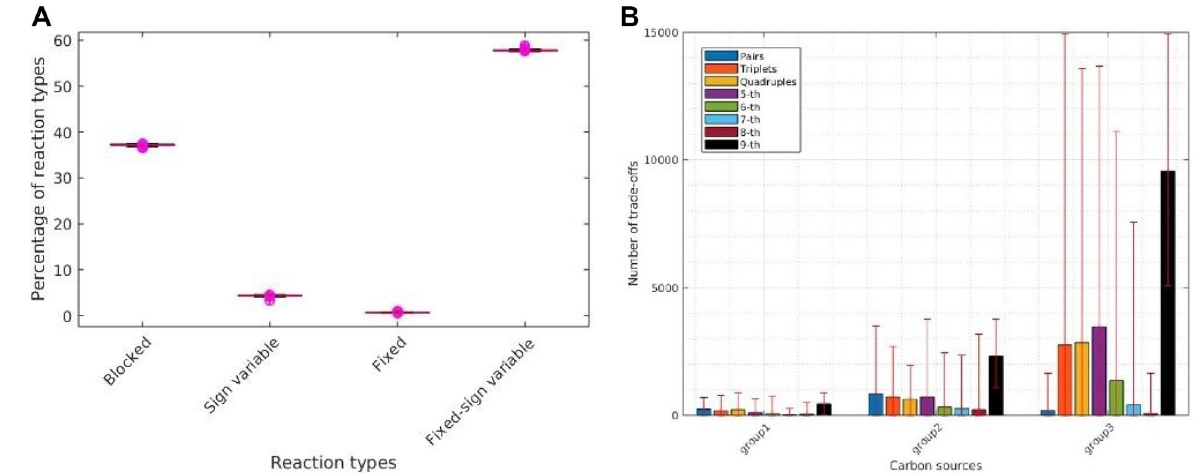
Figure 3. Reaction types based on variability and trade-offs types in E. coli grown under different carbon sources. (A) Box plots showing the percentage of the four reaction types across the 53 carbon sources. (B) Numbers of trade-offs involving a different number of reactions for the 53 growth conditions group in three categories, group 1: (S)-Propane-1,2-diol, N-Acetyl-D-mannosamine, Butyrate (n-C4:0), D-Galactose, D-Glucuronate, Maltose, L-Rhamnose, N-Acetylneuraminate, D-Alanine, L-Asparagine, L-Alanine, Octadecenoate (n-C18:1), Melibiose. group 2: Dihydroxyacetone, L-Fucose ,Acetoacetate, Adenosine, 2-Oxoglutarate, Fumarate, Galactitol, L-Glutamine, L-Lyxose, D-Malate, Maltotriose, D-Mannose, Pyruvate, Succinate, Trehalose, L-Aspartate, L-Glutamate, Inosine. group 3: 5-Dehydro-D-gluconate,